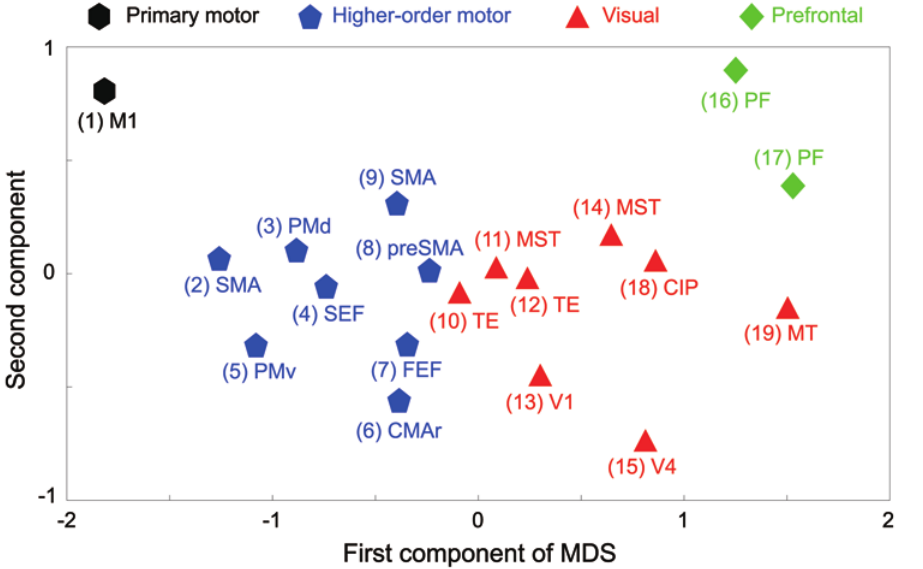
Figure 4. A MDS map of cortical neuronal firing based on LvR . The map plots the first and second components of Kruskal’s nonmetric multidimensional scaling (MDS) analysis for the Hellinger distances of the metric distributions for all combinations of 19 neuronal data sets. The primary motor, higher-order motor, visual, and prefrontal areas are indicated by black hexagons, blue pentagons, red triangles, and green squares, respectively. The number in brackets next to the notation for each cortical area indicates data sets 1–19 shown in Figure 3C and Table 1.